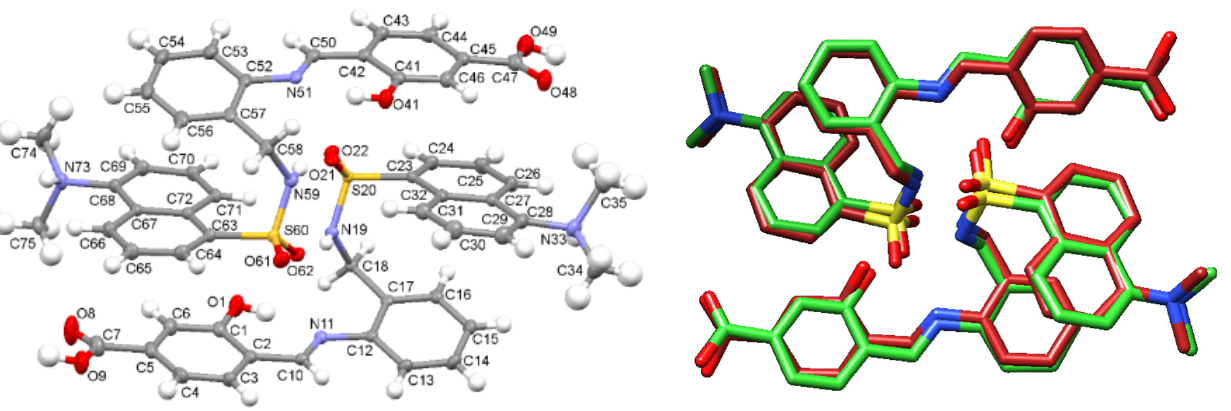
Figure 1. (Left ): Ellipsoid view of the molecular structure of the two H 4 L + cations present in the asymmetric unit of [H 4 L]Cl · 0.92H 2 O crystals. ( Right ): Superimposition of the experimental structure and the theoretically calculated one (M062X/6-31G*) as sticks diagrams.